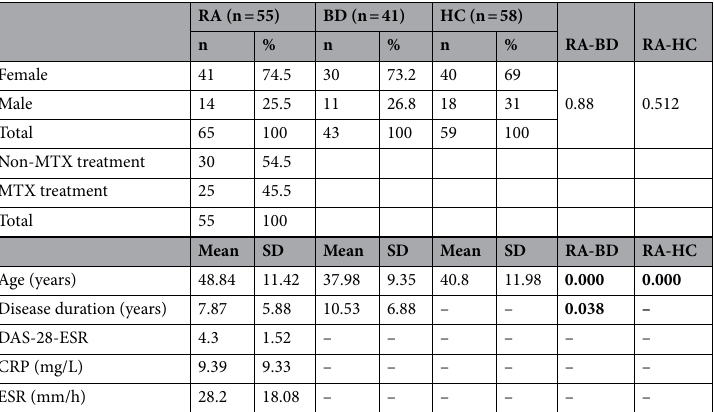
Table 1. Overview of the clinical characteristics of the study cohort. On the right side of the table, the two last columns display p values from pair of groups comparisons (Mann–Whitney, p = 0.05). Significant p values are bolded. RA rheumatoid arthritis, BD Behçet’s disease, HC healthy control, DAS-28-ESR 28-joints disease activity score based on erythrocyte sedimentation rate, CRP C-reactive protein, ESR erythrocyte sedimentation rate, MTX